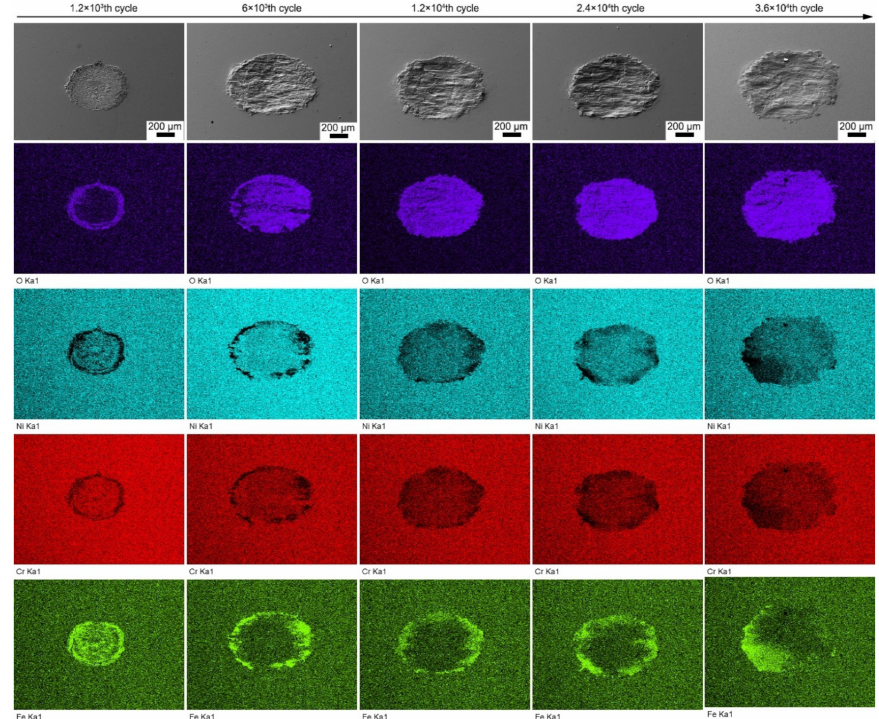
Figure 5. The overall SEM images of wear scars of alloy 690TT with the elemental mapping of O, Ni, Cr, and Fe at di ff erent cycle